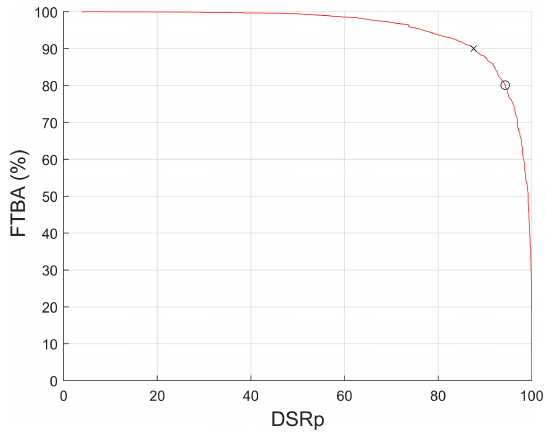
Figure 4. Fraction of total burnt area (FTBA) vs DSR percentile (DSRp), computed for mainland Portugal during the period 2001– 2019. The circle (cross) is the DSRp when the FTBA reaches 80% (90%).